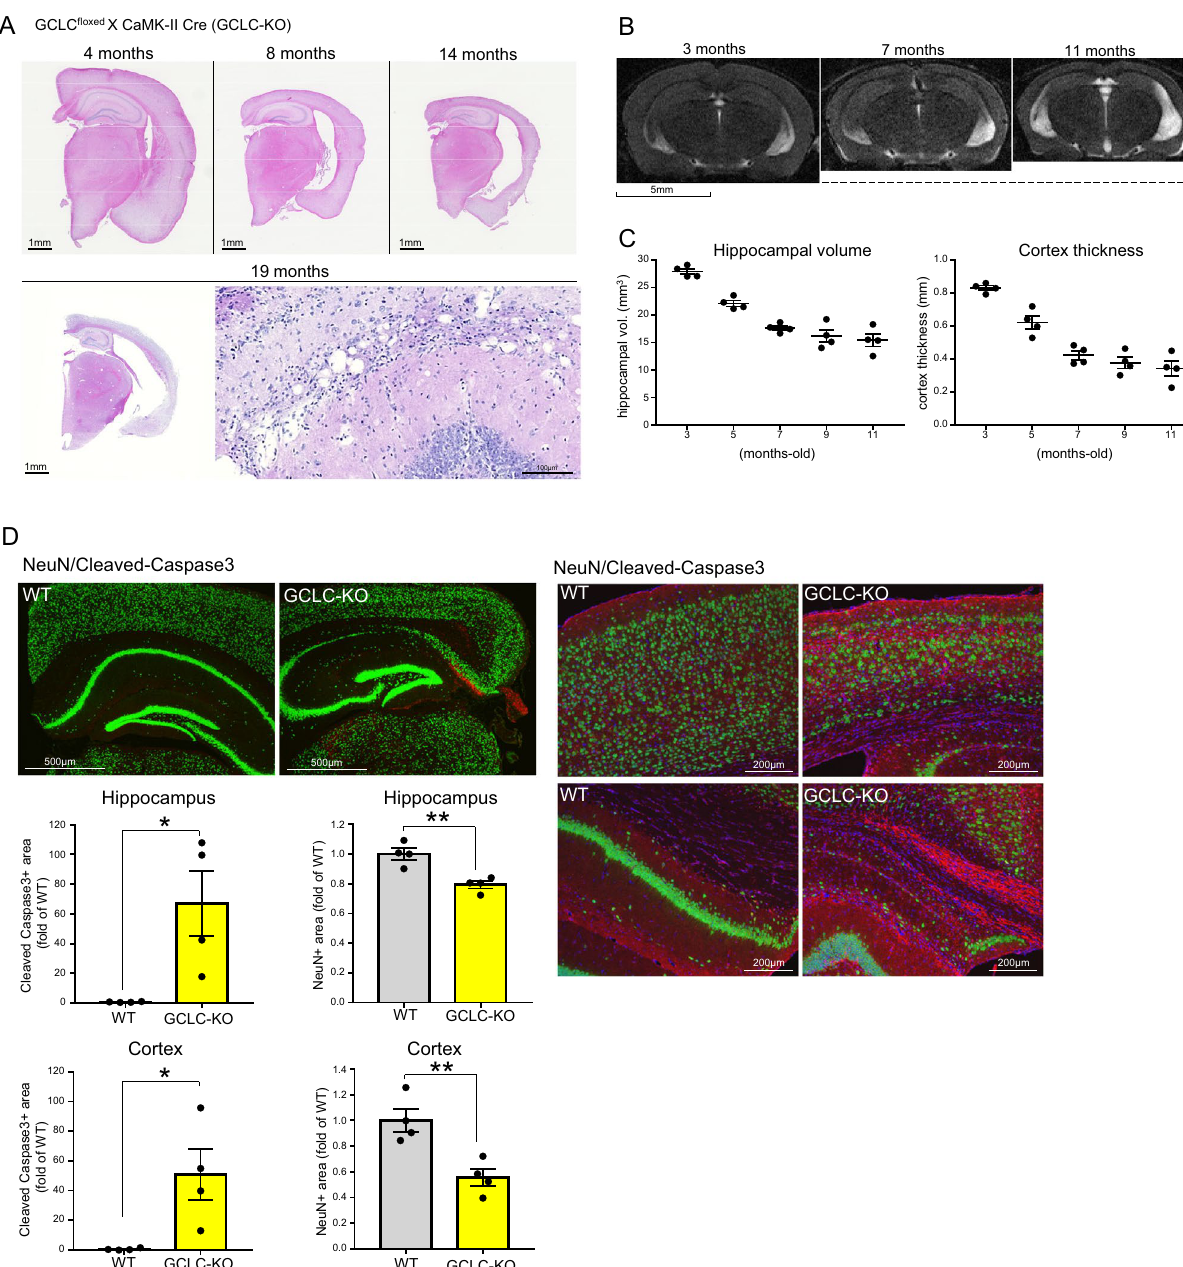
Figure 1. Neuronal GCLC-deficiency leads to brain atrophy due to neuronal loss. ( A ) Brain sections from 4-, 8-, 14- and 19-month-old GCLC-KO were stained by H&E. Lower right panel shows a magnified image of a 19-month-old mouse brain. ( B ) Representative MRI scans of GCLC-KO mouse brains scanned every 2 months from 3 to 11 months of age. ( C ) Values shown in the graph represent the mean bilateral hippocampal volume calculated from 8–9 scanned MR images (left) and cortical thickness measured from several images (right) ± SEM (n = 4; * p < 0.05, ** p < 0.01). ( D ) Brain sections of 8-month-old GCLC-KO and WT were immunostained for NeuN (green)/cleaved-caspase 3 (red). Right panels were confocal MIP images of cortex (Upper panels) and hippocampal CA1(Lower panels) region. Values shown in the graphs are the fluorescence intensity of NeuN and caspase 3 with the results expressed as the mean relative levels ± SEM (n = 4; * p < 0.05, ** p <